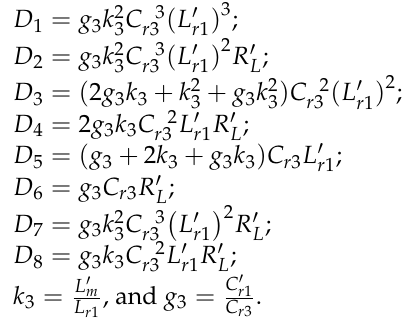
Table 2. Selected specifications of the converter.